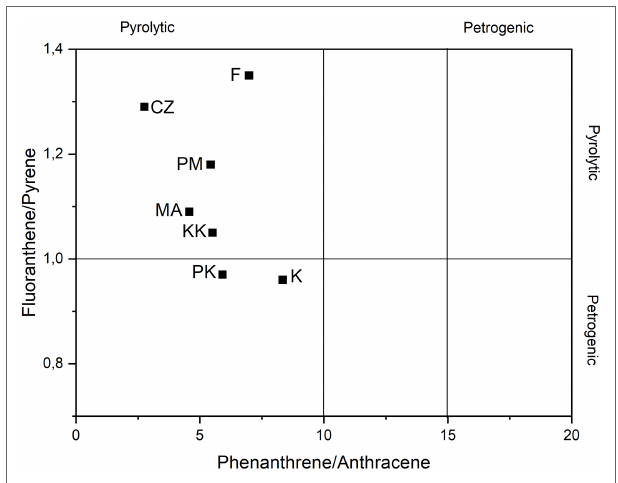
FIGURE 3 | Cross plot of phenanthrene/anthracene and fluoranthene/pyrene ratios (average